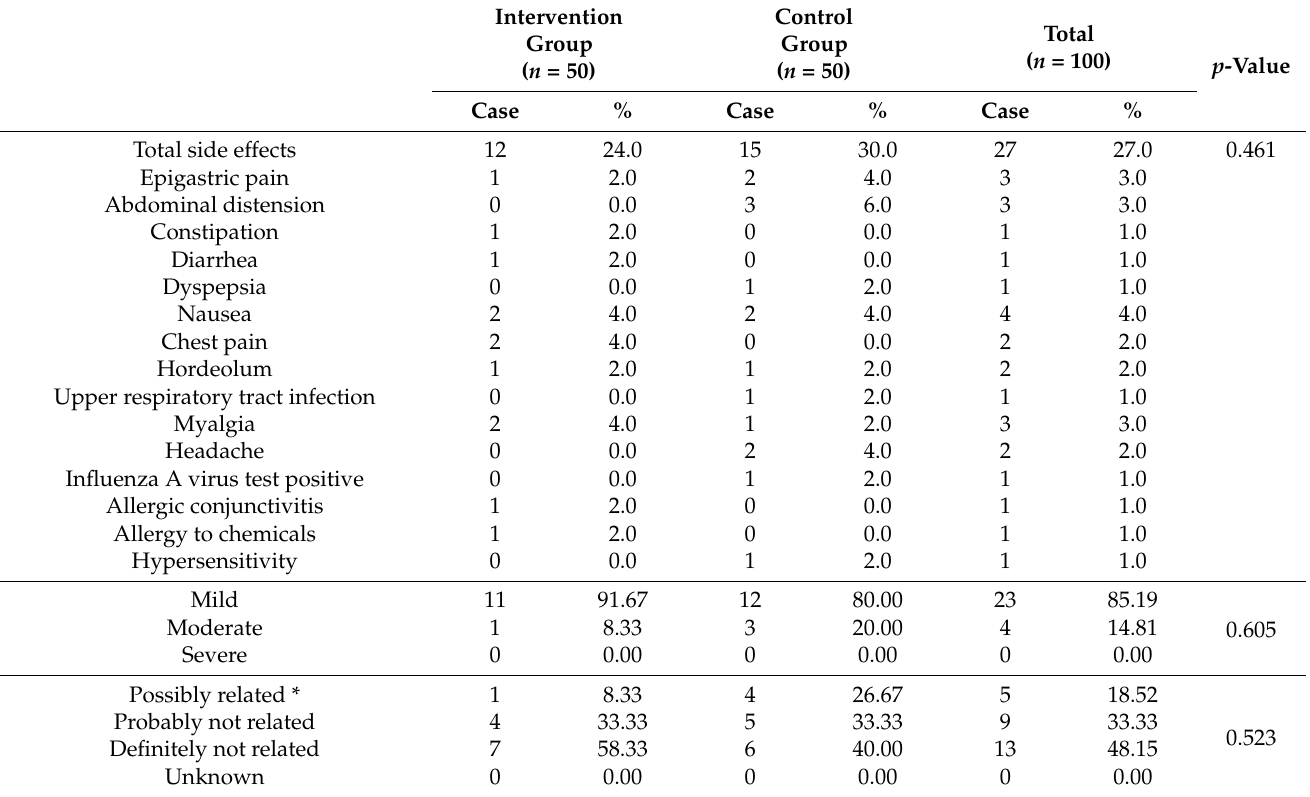
Table 3. Side effects in this